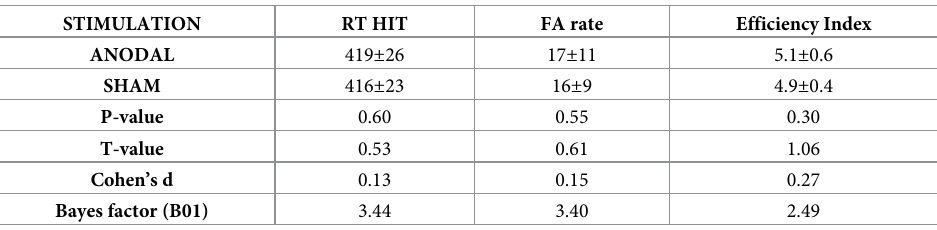
Table 1. Behavioral results. Anodal vs. sham